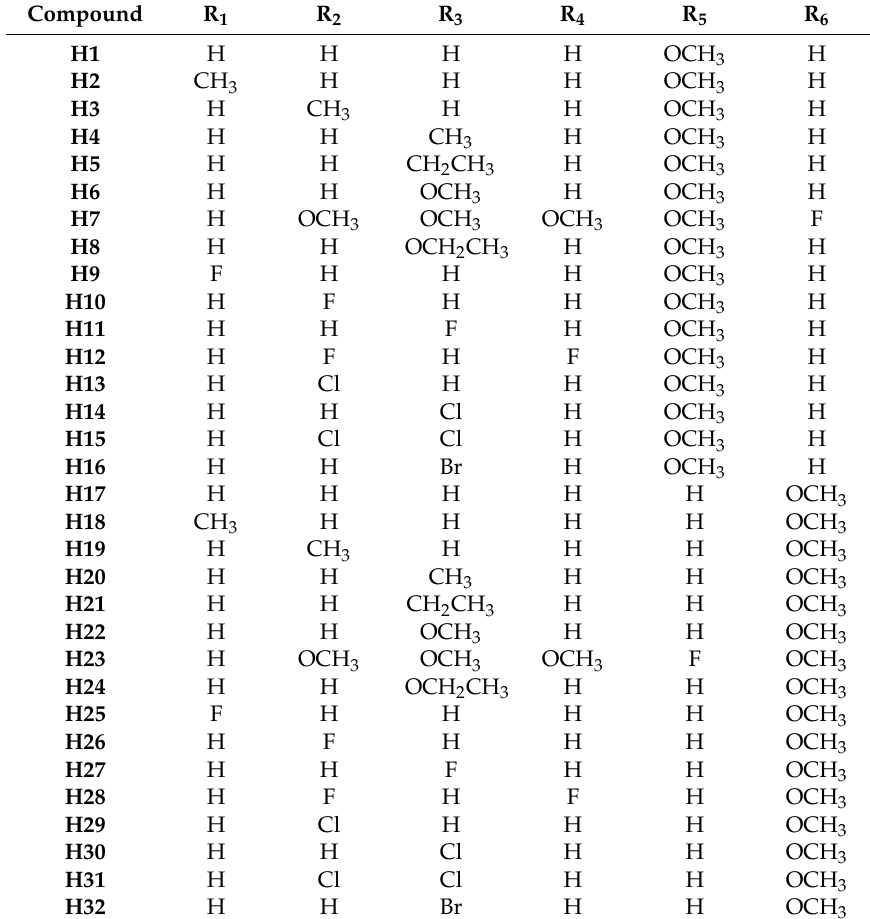
Table 1. Structures of compounds H1 – H32